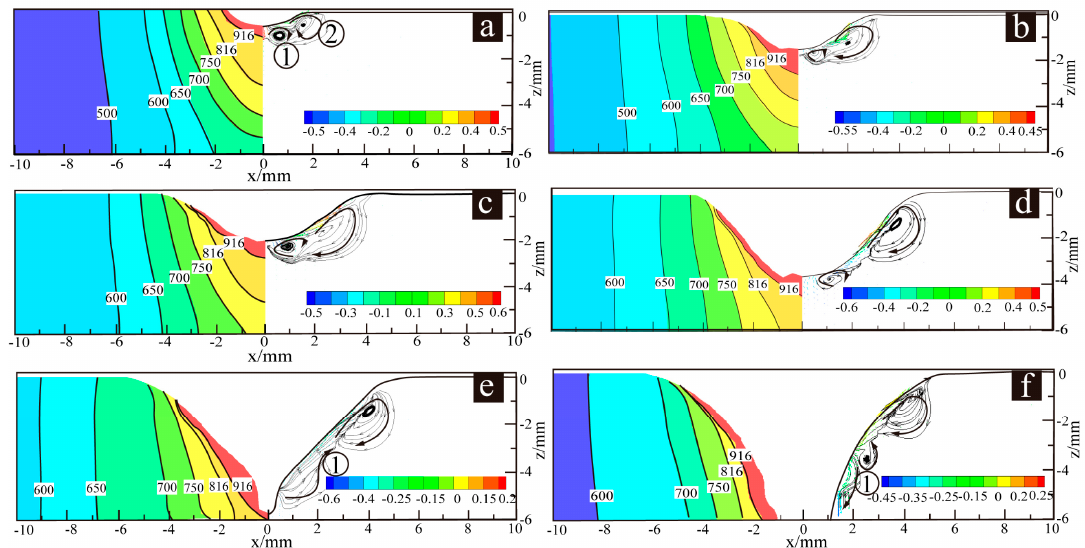
Figure 8. Longitudinal sectional of temperature and velocity distribution during keyhole formation process of case a ( a ) 1.72 s, ( b ) 2.43 s, ( c ) 3.32 s, ( d ) 3.65 s, ( e ) 4.34 s, ( f ) 4.55 s.